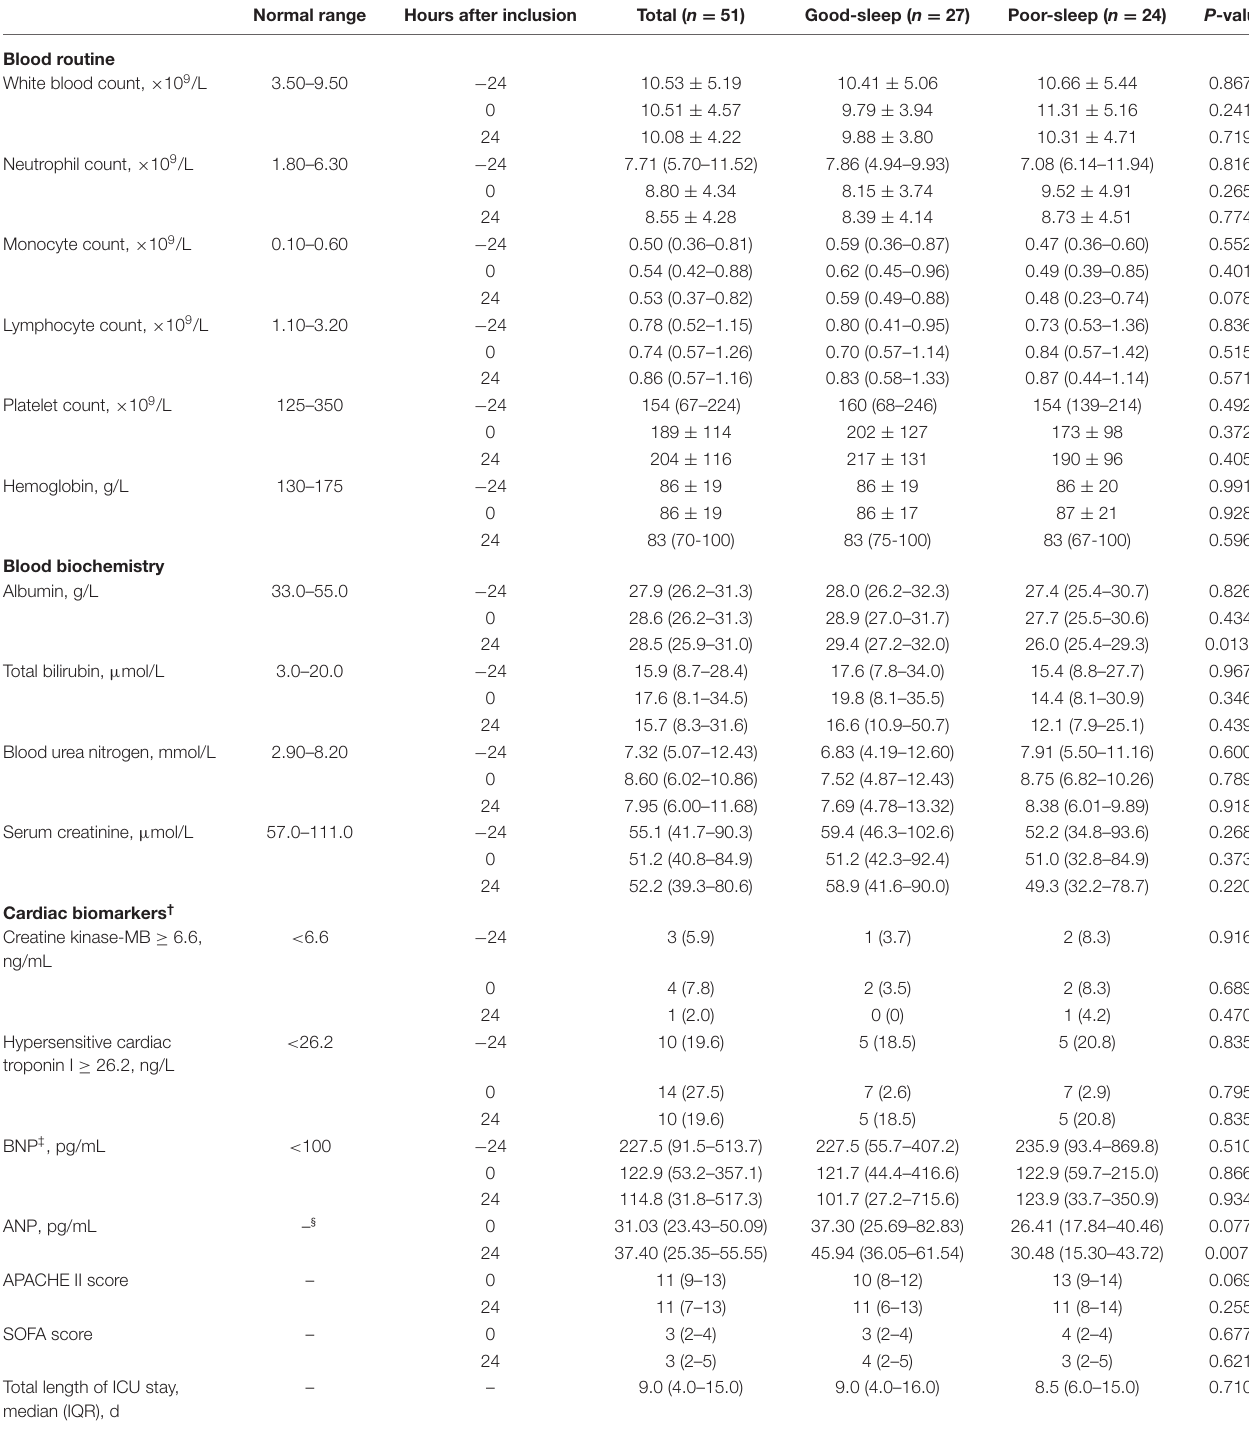
TABLE 3 | Laboratory parameters at − 24, 0 and 24h after inclusion, and total length of ICU stay. Normal range Hours after inclusion Total ( n = 51) Good-sleep ( n = 27) Poor-sleep ( n = 24) P